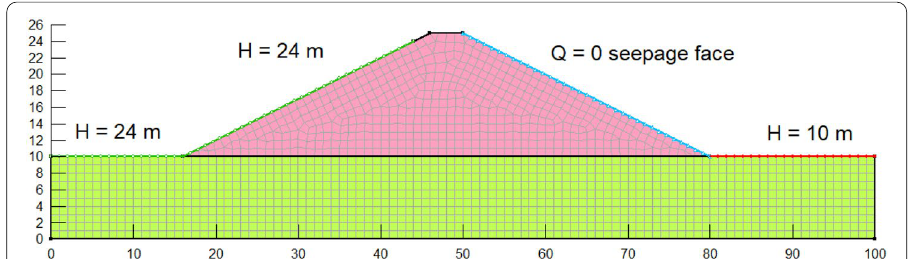
Fig. 3 A typical model of the homogeneous earthen dam with different boundary conditions as applied for Seep/W